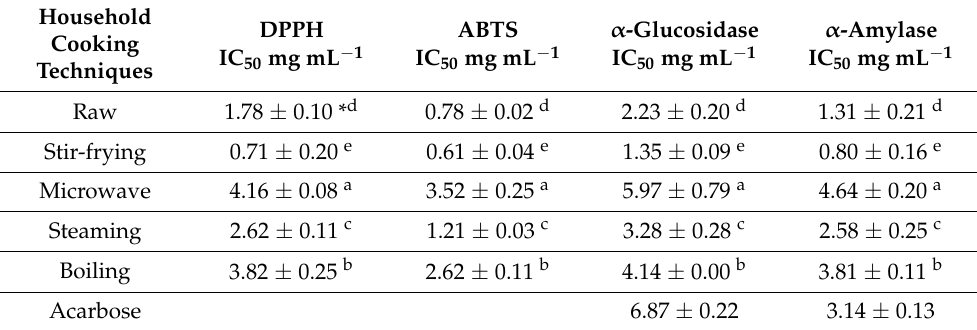
Table 3. Effects of household cooking techniques on antioxidant and antidiabetic activities of African pumpkin leaves ( Momordica balsamina